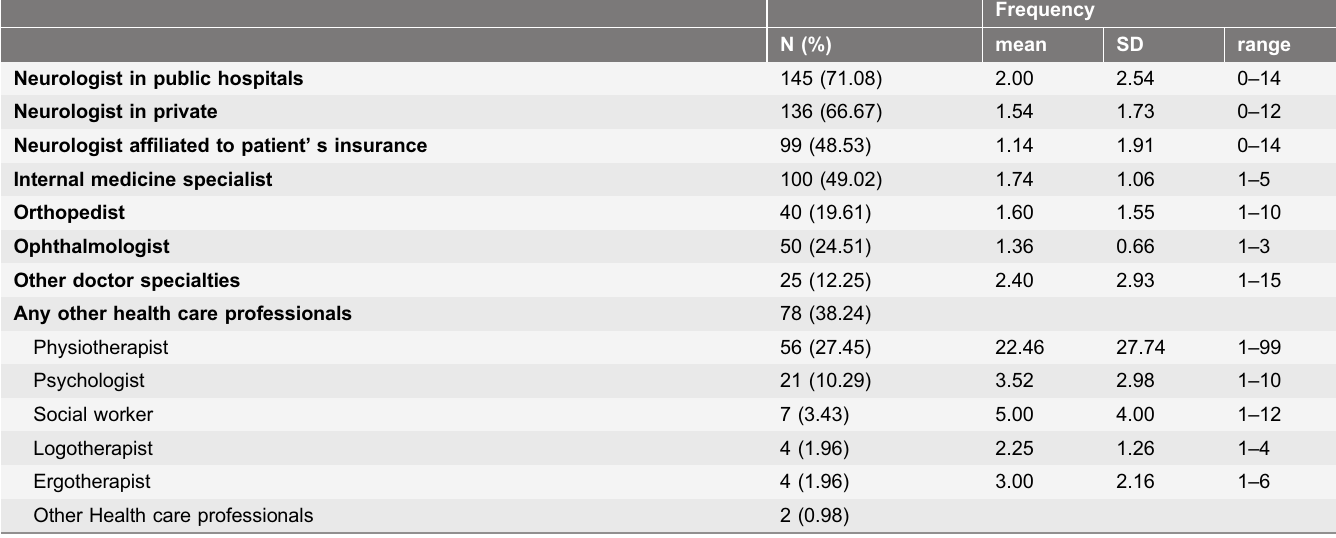
Table 3. Health care service use related to visits to neurologists, other doctors and health professionals.